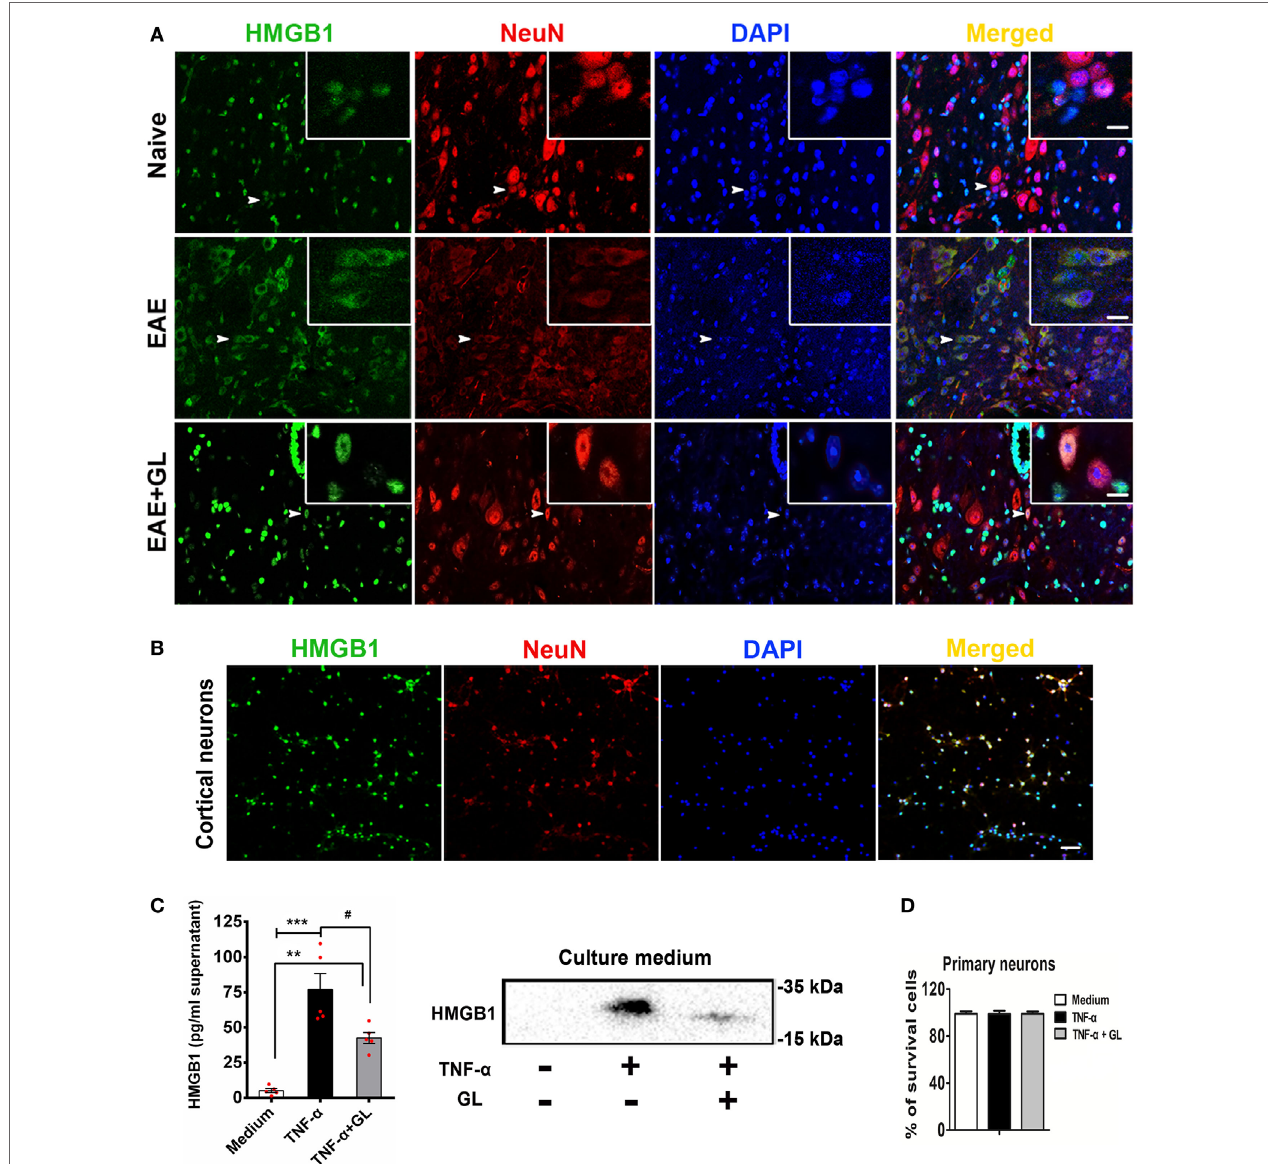
FigUre 6 | Translocation and release of high-mobility group box 1 (HMGB1) in neurons. (a) The translocation of HMGB1 in neurons of experimental autoimmune encephalomyelitis (EAE) mice. Representative images of DAPI (blue), HMGB1 (green), and NeuN (red) staining in the central canal of the spinal cord. Co-localization of HMGB1 and NeuN-positive cells is indicated by white arrows. White boxes in the merged images are magnified regions. n = 4 animals in each experimental group, and representative images are shown. Scale bars: 50 µm. (B) The localization of HMGB1 in primary cultured cortical neurons. Immunostaining of neurons with HMGB1 (green), NeuN (red), and DAPI (blue); representative images are shown. Scale bars: 50 µm. (c) ELISA and Western blotting were used to detect HMGB1 in the culture medium of primary cultured cortical neurons. Neurons were stimulated with tumor necrosis factor-alpha (TNF- α ) (200 ng/mL) in the absence or presence of GL (3 mmol/L) for 18 h, and culture media were collected and concentrated using ultrafiltration tubes for subsequent ELISA and Western blot analysis. Data are shown as the mean ± SEM, n = 5 of each experimental group. ** P < 0.01, *** P < 0.001 vs Medium group; # P < 0.05 vs TNF- α group, using one-way ANOVA followed by Bonferroni’s test. (D) The survival rate of neurons was determined with Trypan blue staining after TNF- α or TNF- α + GL stimulation. The results shown are representative of three independent